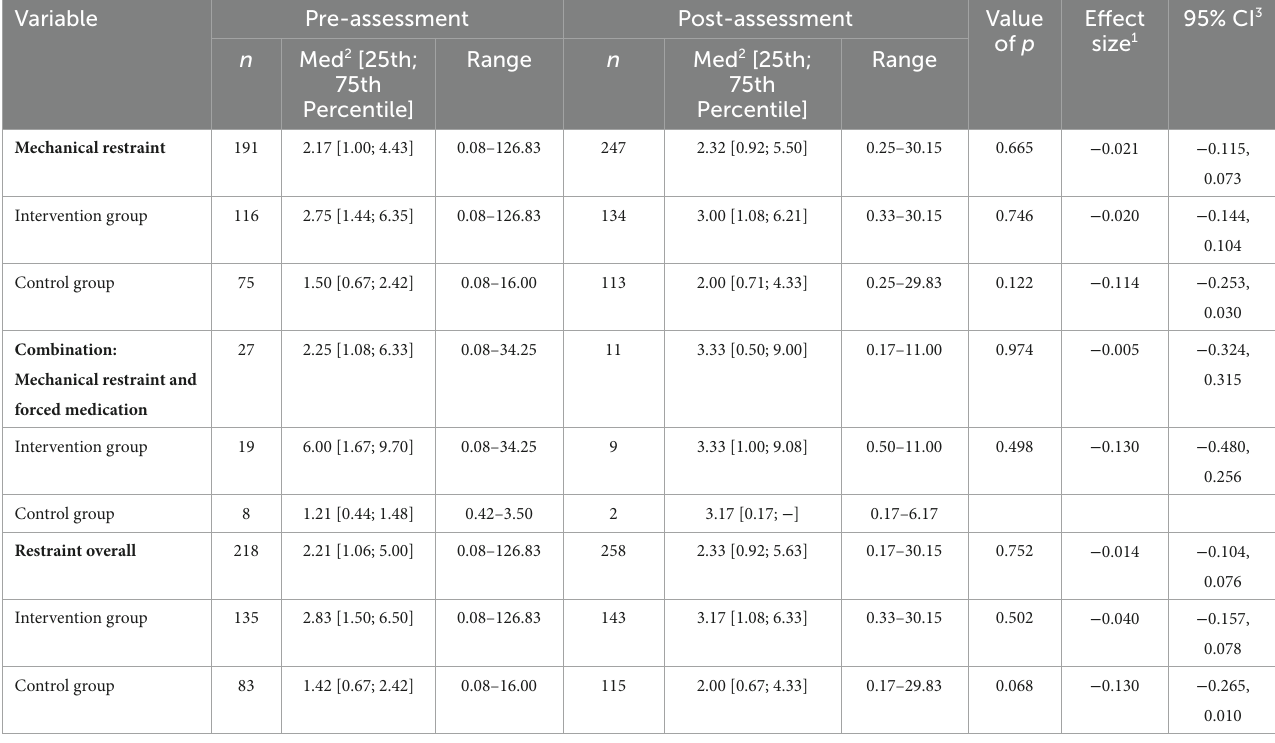
TABLE 3 Duration (in hours) of events of restraint with regard to the total number of events of restraint separated by group (IG or CG) before (pre) and after (post) the implementation of peer support ( n = 476). Variable